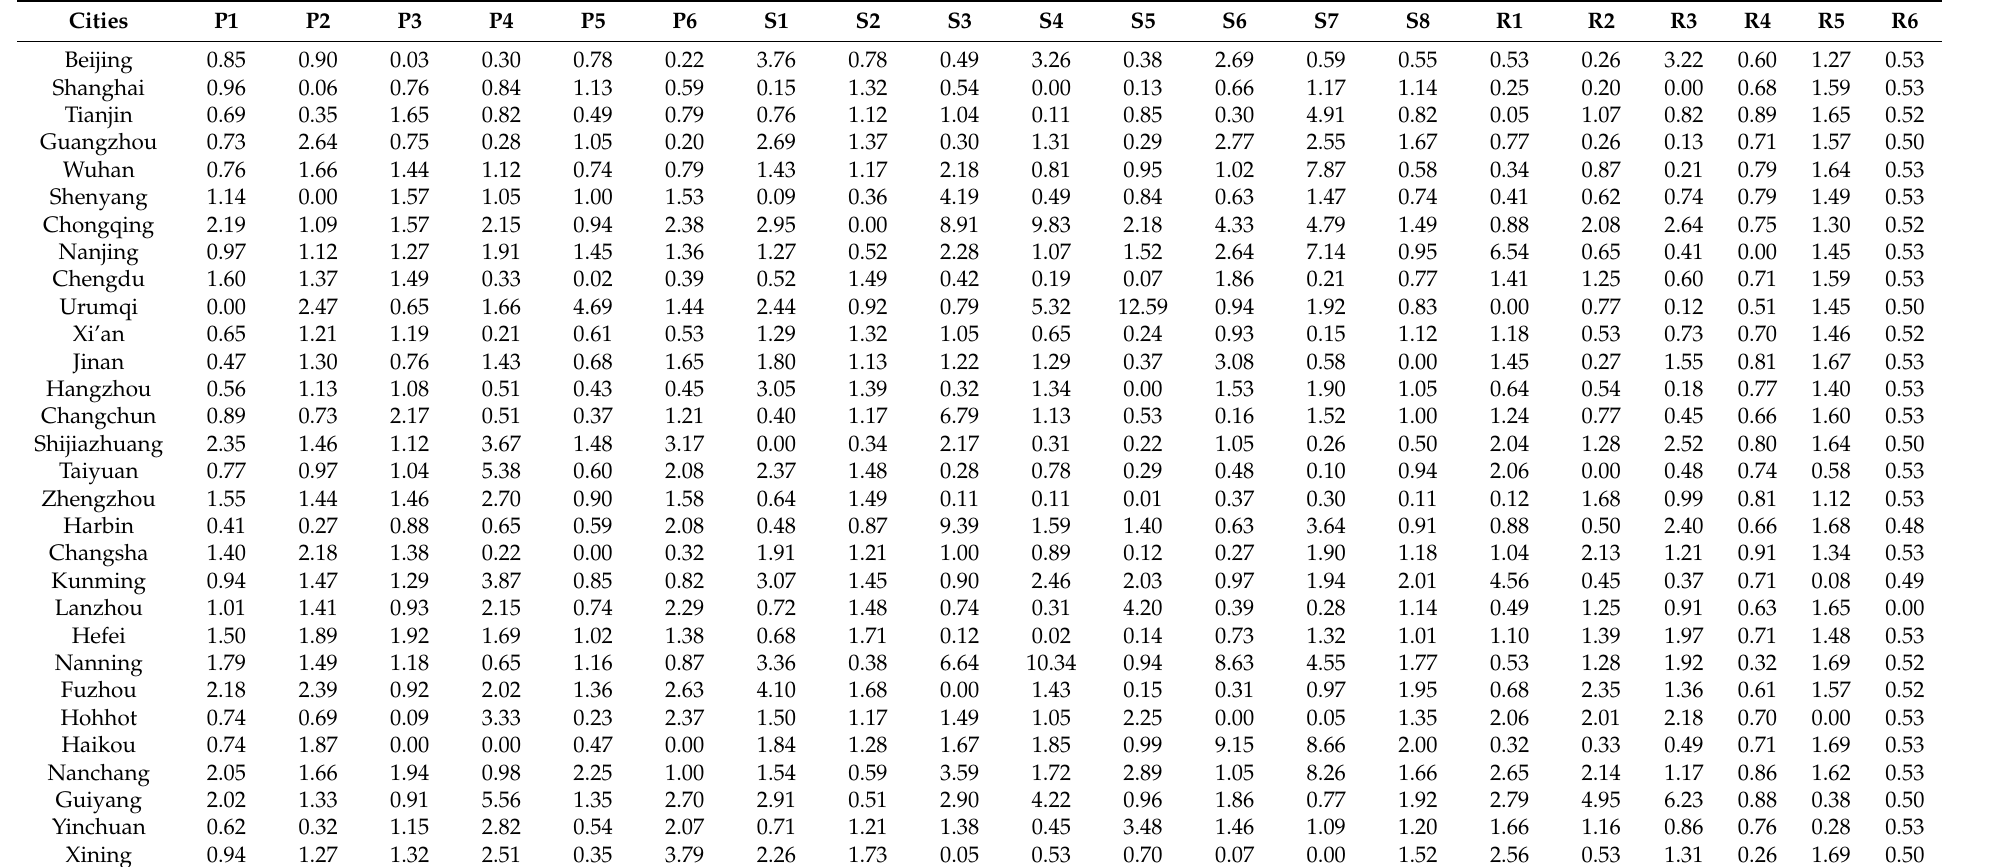
Table A2. The weighted data of UGEI indicators by entropy weight